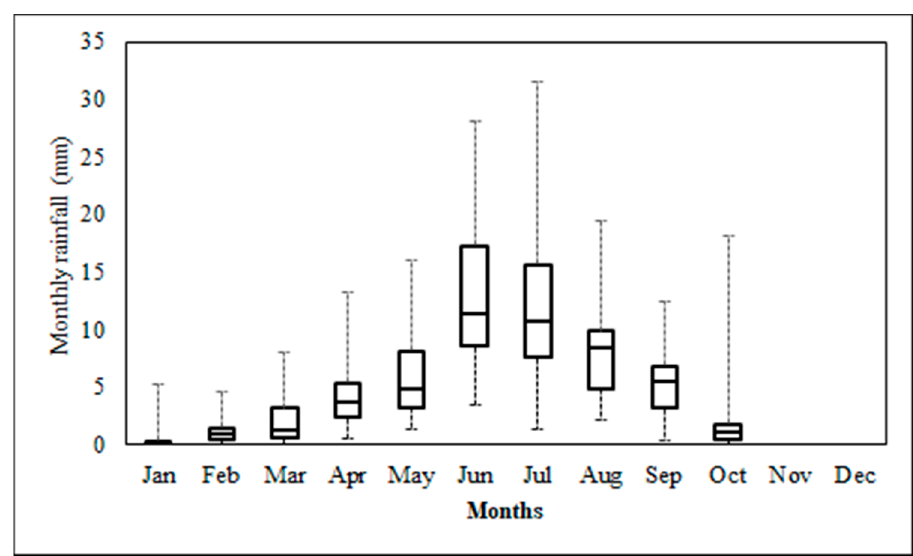
Figure 3. Box and whisker plots showing the annual variation of monthly rainfall measures in the study area for the 11-year period 2004–2014.